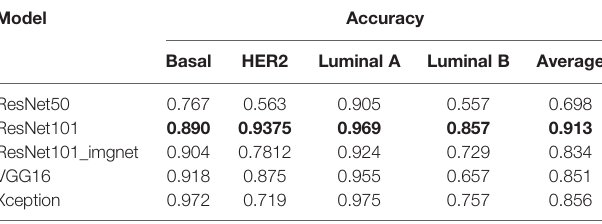
TABLE 3 | Slide-wise model performance on the testing set.